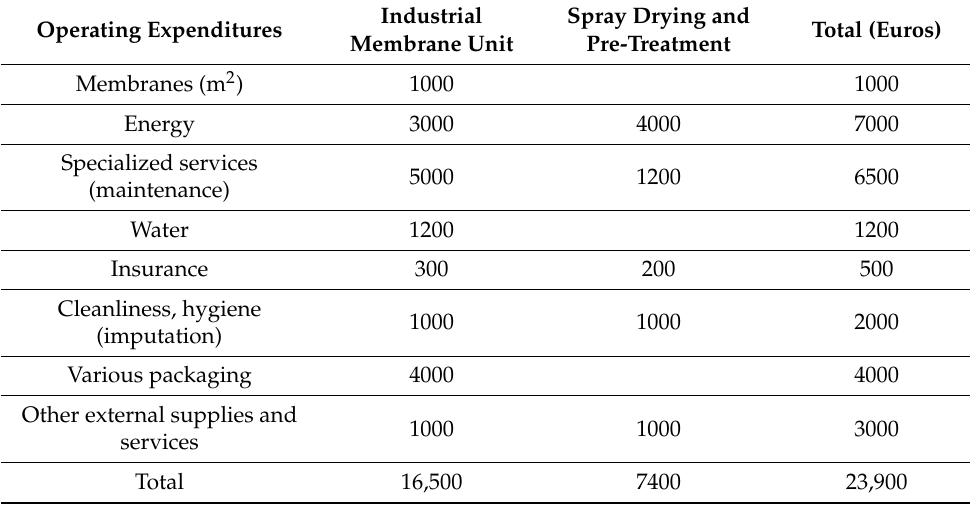
Table 6. Operating costs